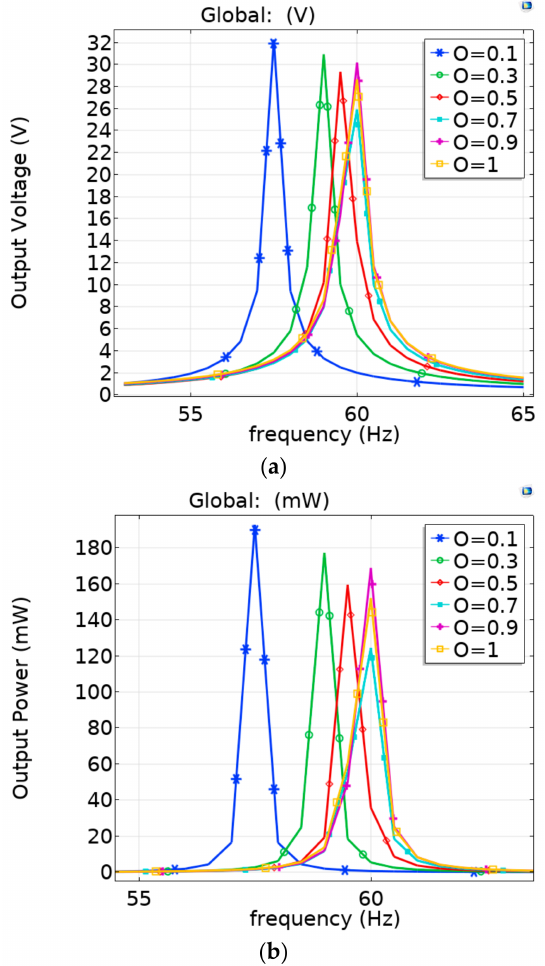
Figure 6. Frequency response of generated output voltage ( a ) and output power ( b ) of the first natural frequency for different tapering ratios of the segmented PVEH for a mechanical input acceleration of 0.5